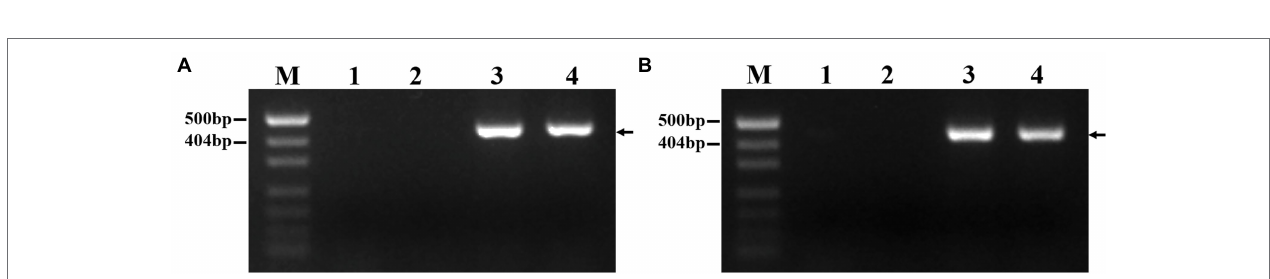
FIGURE 6 | PCR amplification of specific molecular markers. (A) PH7Ns-12, (B) PH7Ns-38. M: Marker (500 bp); 1: CS; 2: CS ph2b ; 3: P. huashanica ; 4: DT23 (wheat- P. huashanica ditelosomic addition line). Arrows show the diagnostic amplification products of P. huashanica 7Ns